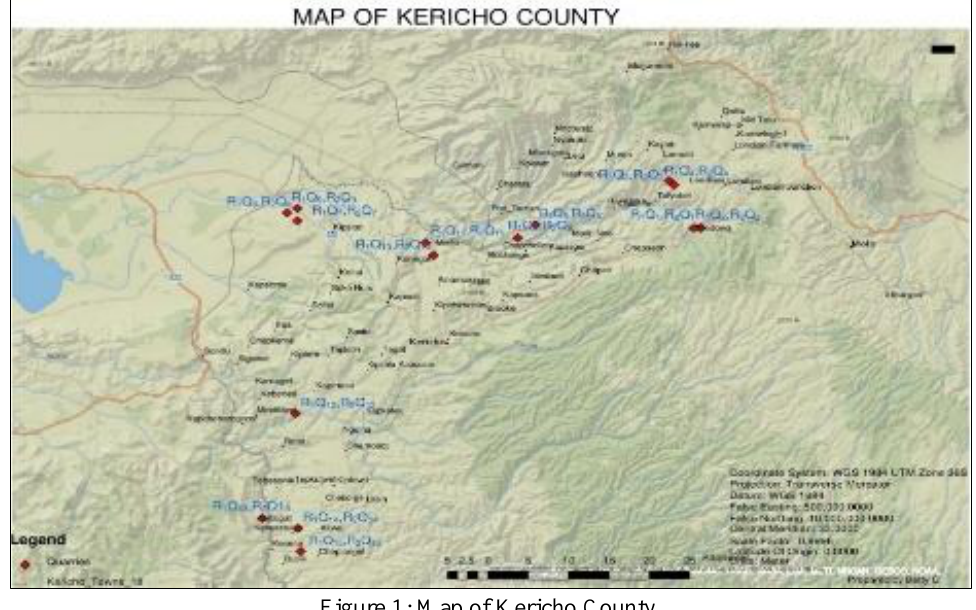
Figure 1: Map of Kericho